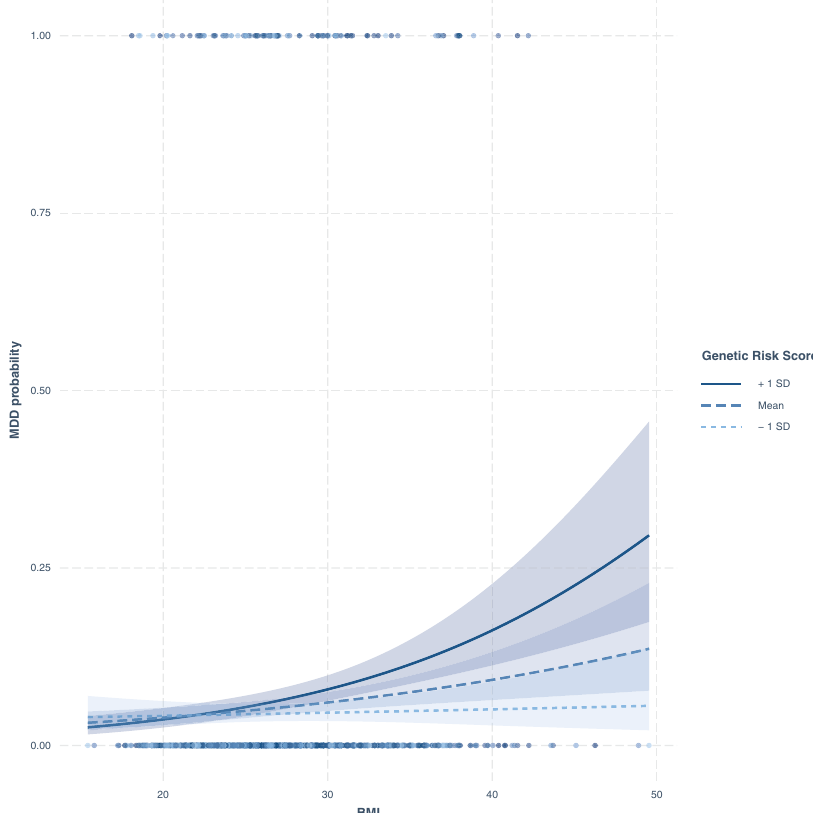
Fig. 3 Graphical representation of the direction and magnitude of the GRS*BMI interaction. BMI body mass index, MDD major depressive disorder, SD standard